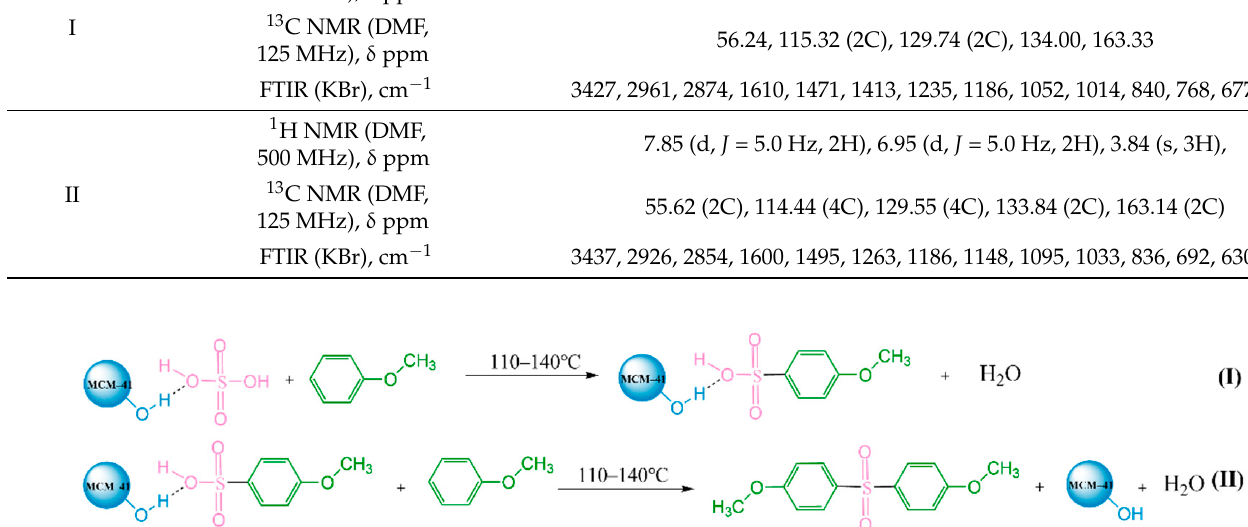
Table 4. 1 H/ 13 C NMR and FTIR results of adsorbed products I and II.